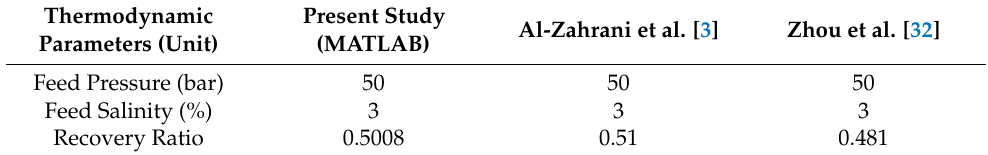
Table 7. Comparison of the obtained reverse osmosis (RO) simulation results with the literature.